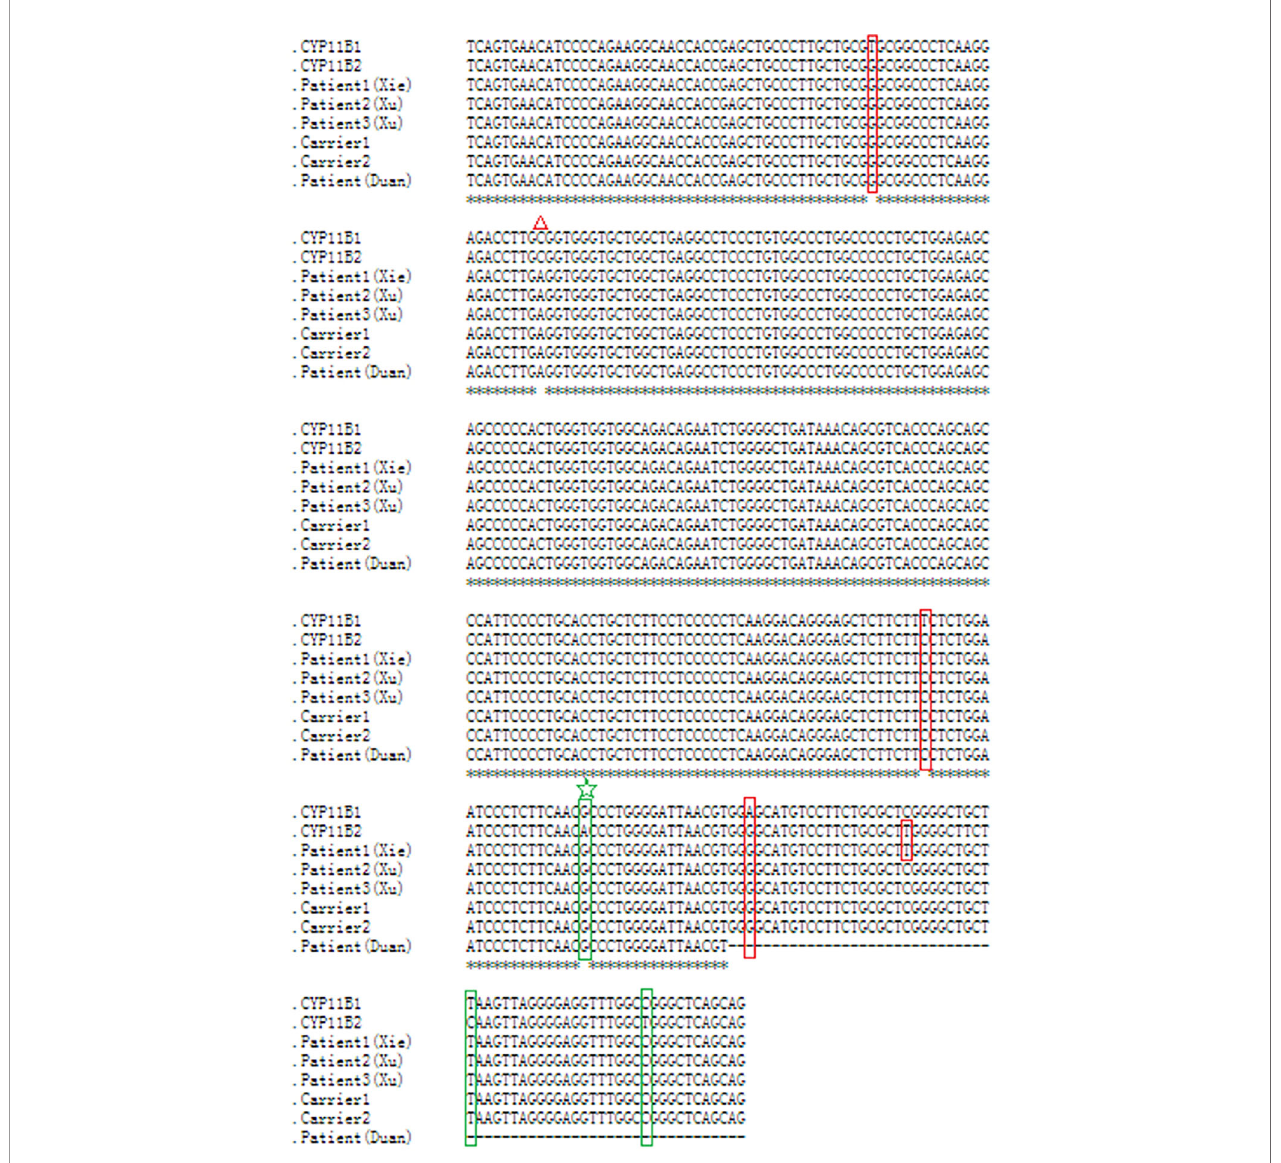
FIGURE 3 | Nucleotide sequence alignment of the chimeric CYP11B2/CYP11B1 gene. Sequence alignment of CYP11B1 and CYP11B2 , and the chimeric CYP11B2/CYP11B1 gene detected from patient 1, carrier 1 and carrier 2 in our study, patient 2 and patient 3 in Xu ’ s study, and the patient in Duan ’ s study using the online Clustal W method (http://www.ebi.ac.uk/Tools/msa/clustalo/). Red boxes indicate CYP11B2 -speci fi c SNPs, and green boxes indicate CYP11B1 -speci fi c SNPs. The red triangle represents a polymorphism in CYP11B2 . The same breakpoint in four patients and two carriers is highlighted with the green star. The black horizontal lines represent the missing downstream sequences in the patient in Duan ’ s